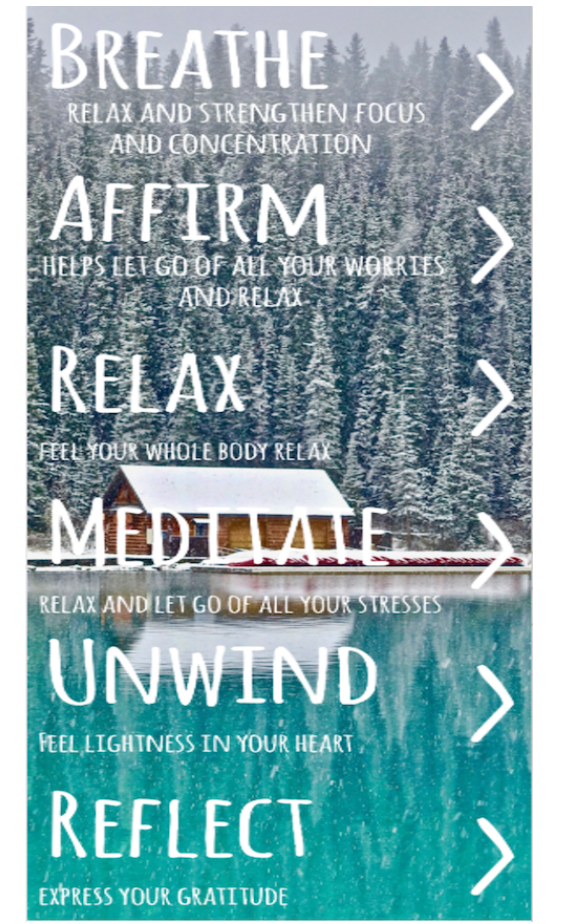
Figure 1. HeartBot